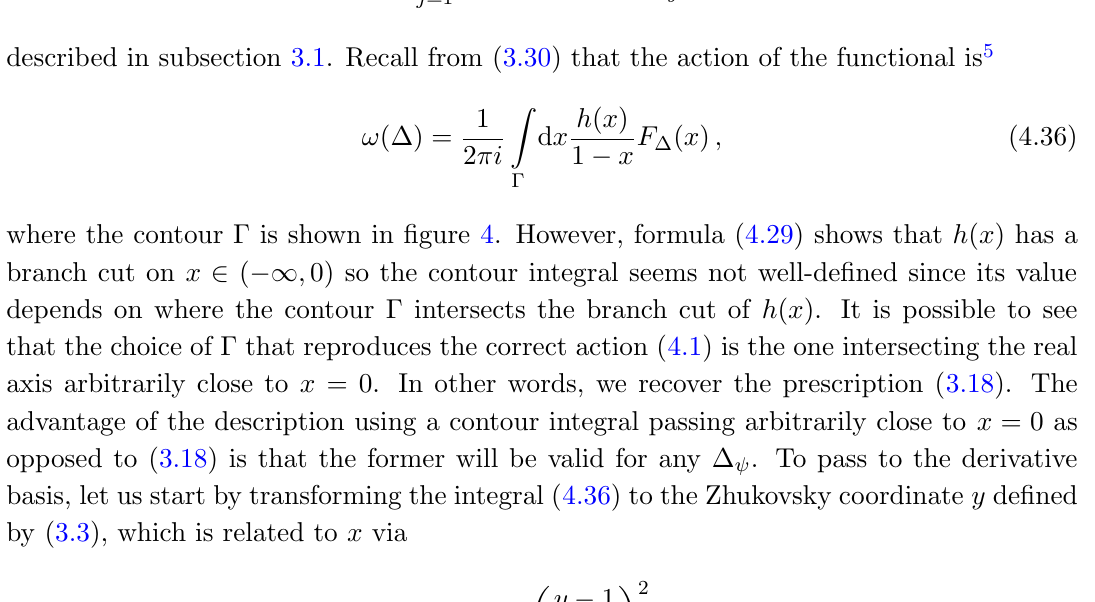
((cid:1)) is plotted in (cid:12)gure 6. As 2 N . The simple pole of (cid:10) 2